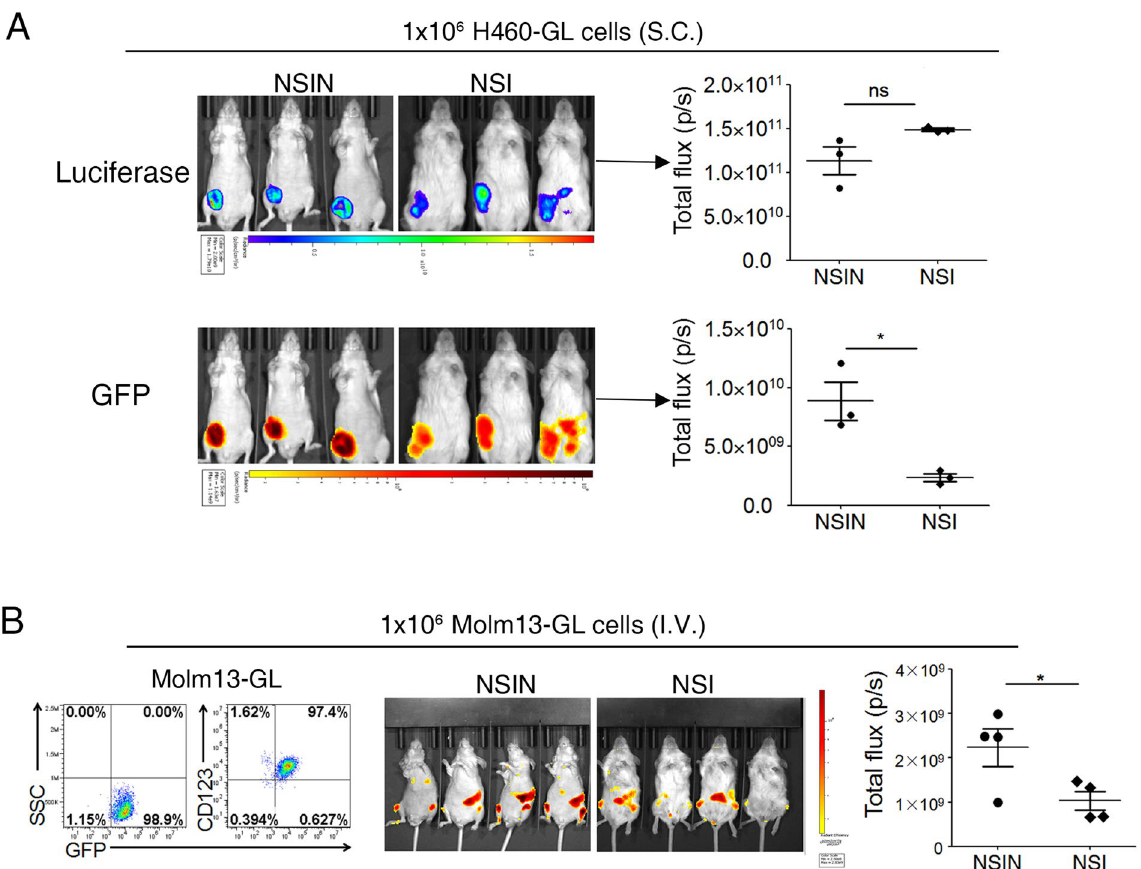
Figure 7. Improved live fluorescence imaging in NSIN mice. ( A ) Live fluorescence imaging of H460-GFP and luciferase (GL)-burdened mice. H460-GL cells (1 × 10 6 ) were subcutaneously injected into NSIN and NSI mice (n = 3 for each group), and luciferase and GFP were analyzed on day 30. Total flux of luciferase-derived and GFP-derived fluorescence was compared between NSI and NSIN mice (right panel). H460-GL, a human large cell lung cancer cell line, expresses GL. ( B ) Live fluorescence imaging of Molm13-GL-burdened